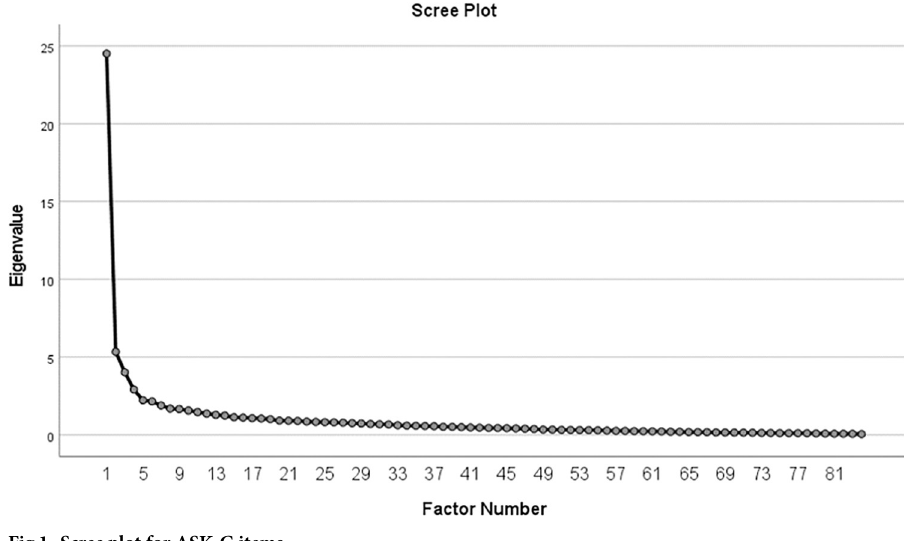
Fig 1. Scree plot for ASK-G